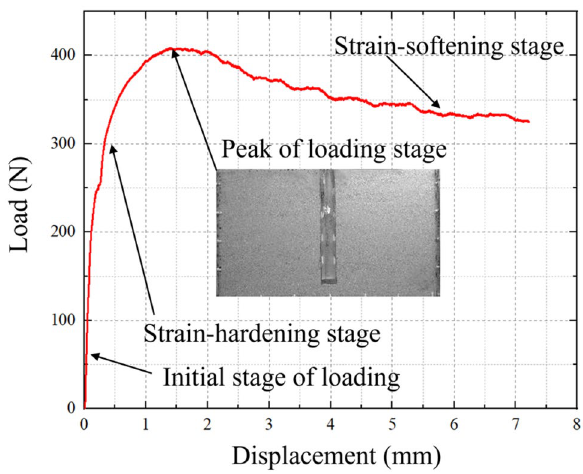
Figure 4. The Q-s curve of pile buried depth with 300 mm.